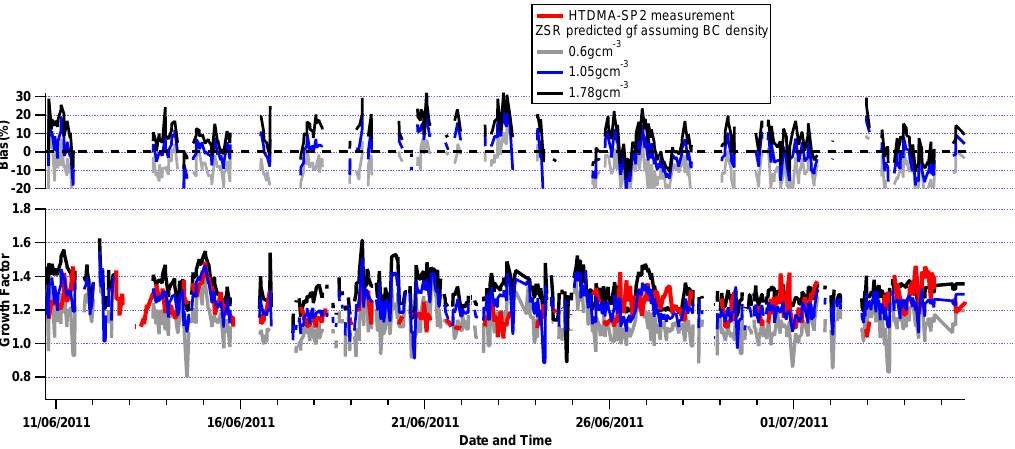
Fig. 10. Time series of the averaged gf for each complete HTDMA scan: HTDMA-SP2 measured gf, ZSR predicted gf by assuming different rBC ρ eff . The top panel shows the biases, given as (gf ZSR - gf HTDMA - SP2 ) /gf HTDMA - SP2 × 100% for each assumed rBC ρ eff .